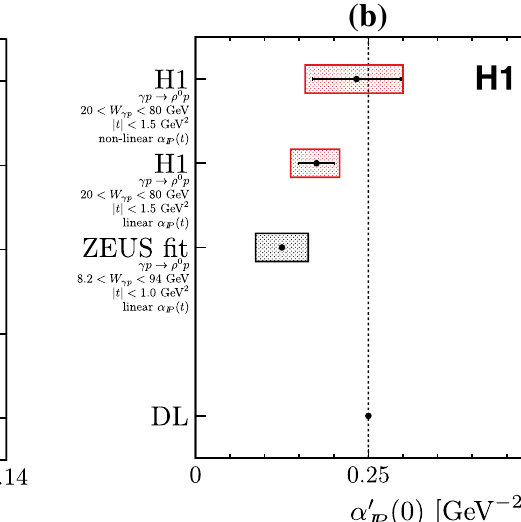
production data [93]. The shaded bands show the total statistical and systematicuncertaintiesoftherespectivemeasurements.Forthepresent data points, the statistical uncertainties alone are indicated by the error